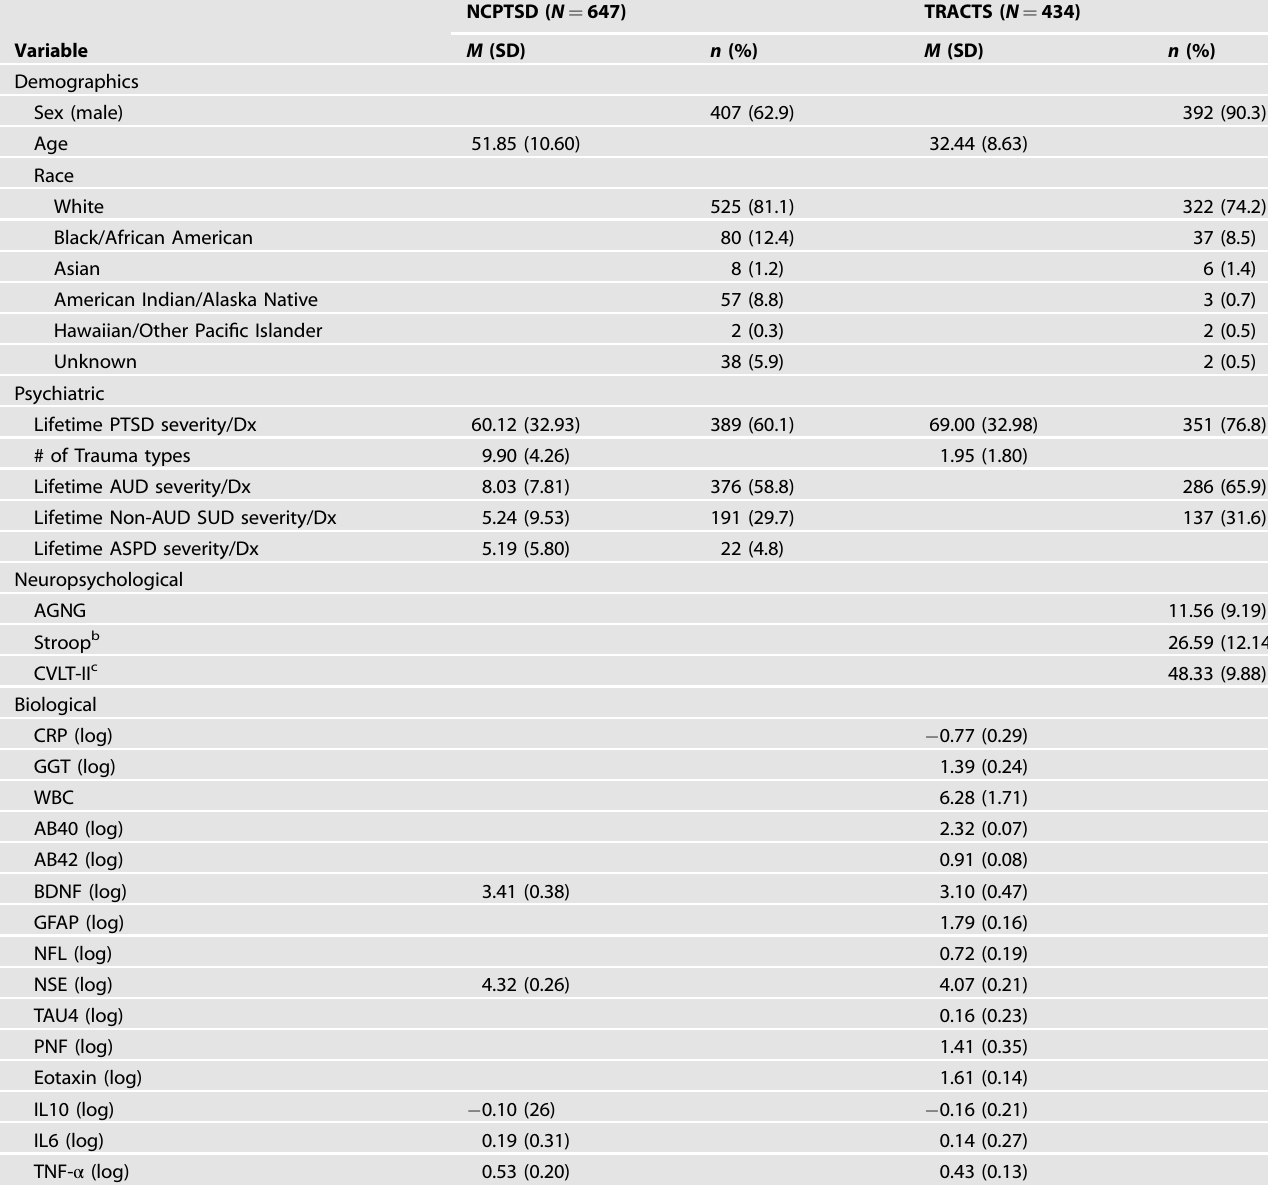
Table 1. Participant characteristics and descriptive